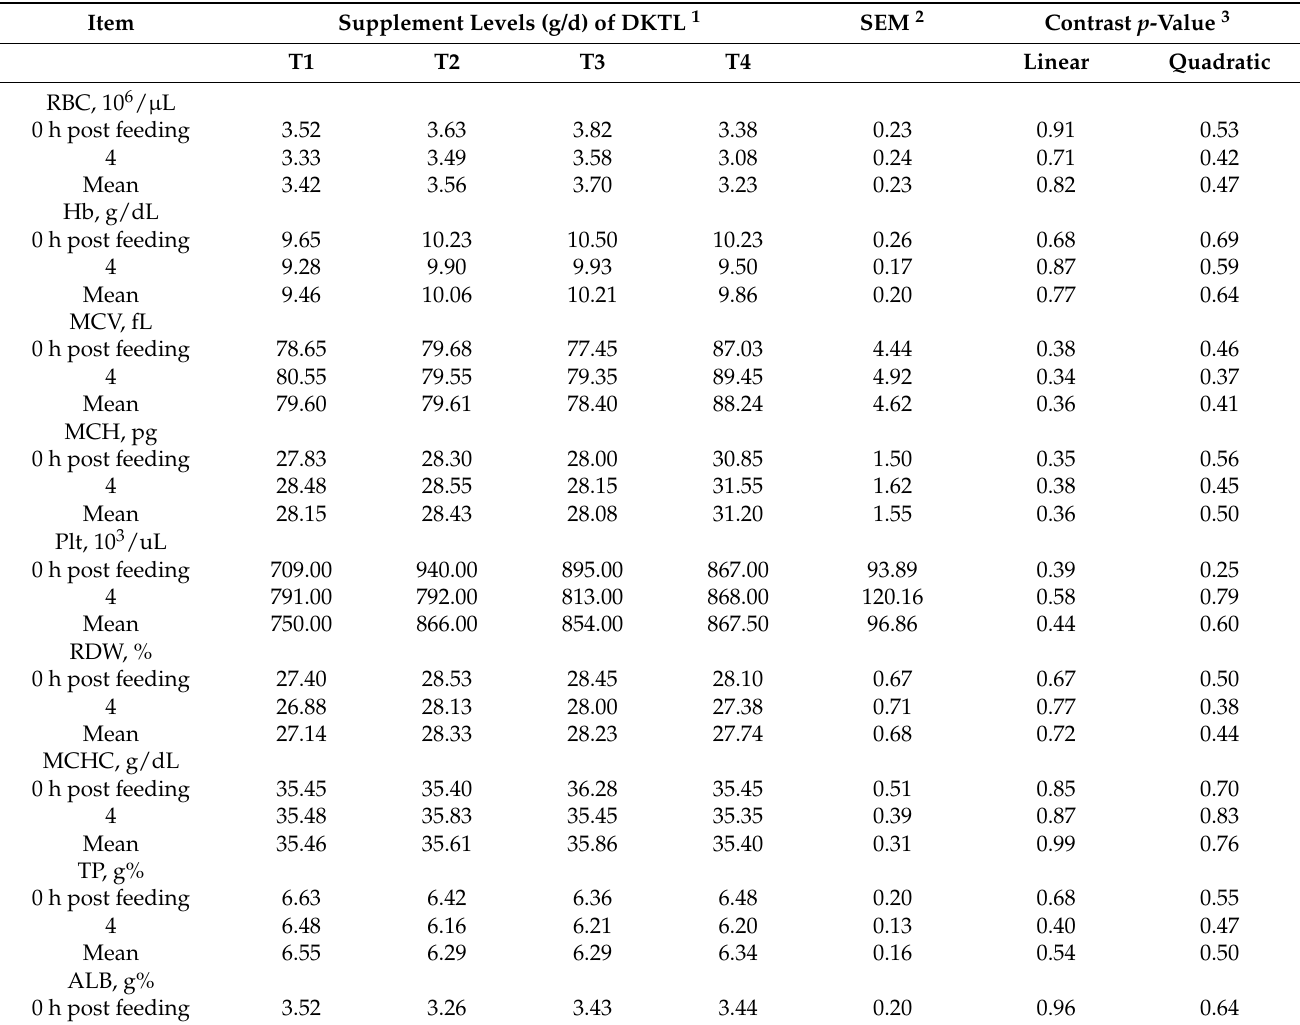
Table 7. Effects of supplement levels (g/d) of dried kratom leaves on complete blood count in